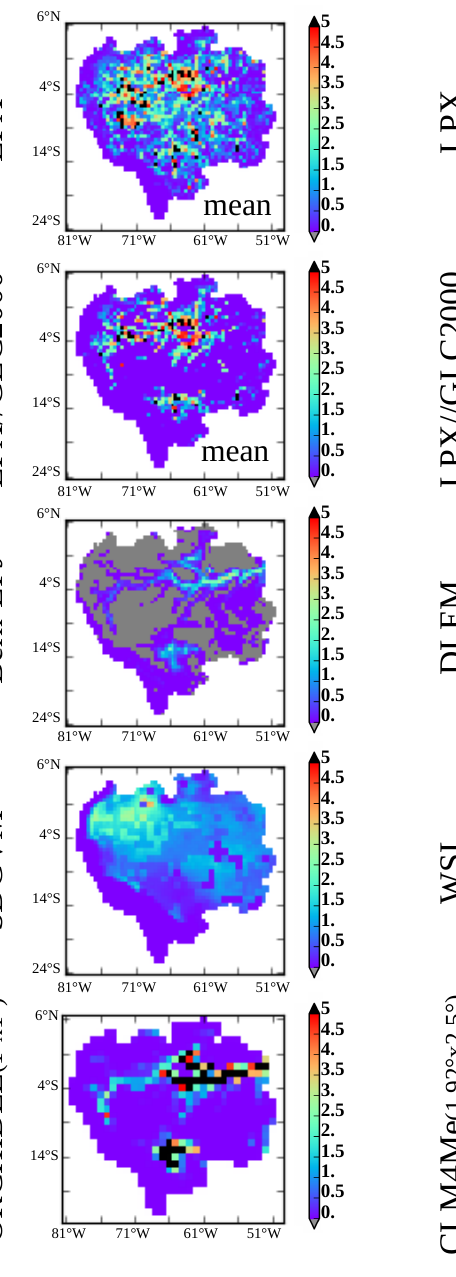
Fig. 10. CH 4 emissions (gCH 4 month − 1 m − 2 of grid cell) for LPX (top line; left: mean between the seven simulations of Table 4; right: std between the same seven simulations) and six models participating in WETCHIMP. The second line (LPX//GLC2000) gives emissions after filtering for grid cells that contain floodplains in GLC2000. Because of the different resolution for ORCHIDEE and CLM4Me, the emissions are given per m 2 of grid